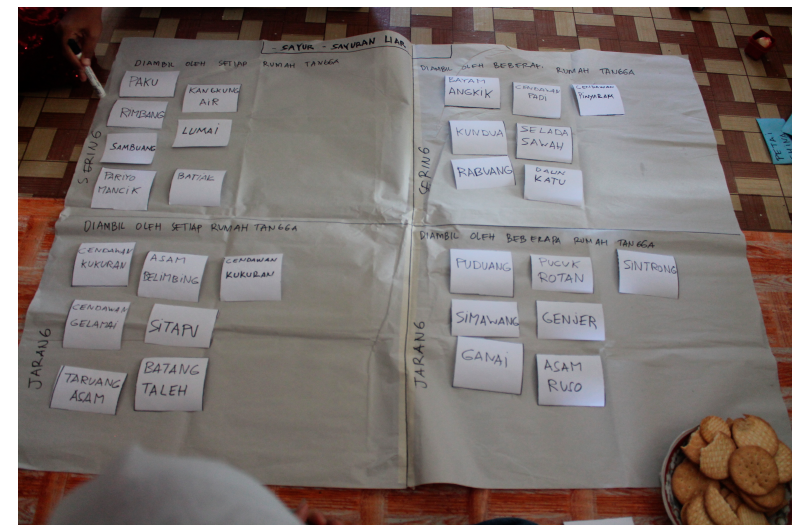
Figure 2. Participatory group assessment of changes in diversity and use of wild food plants through the 4-cell analysis method (Simpang village, June